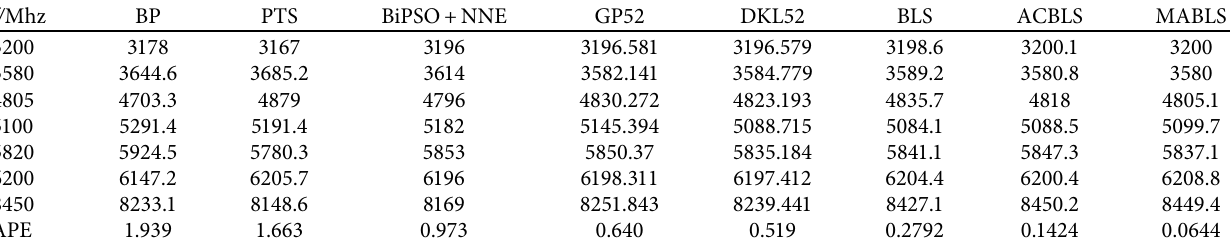
Table 3: Results of different models on